Question: Describe this figure in one sentence.
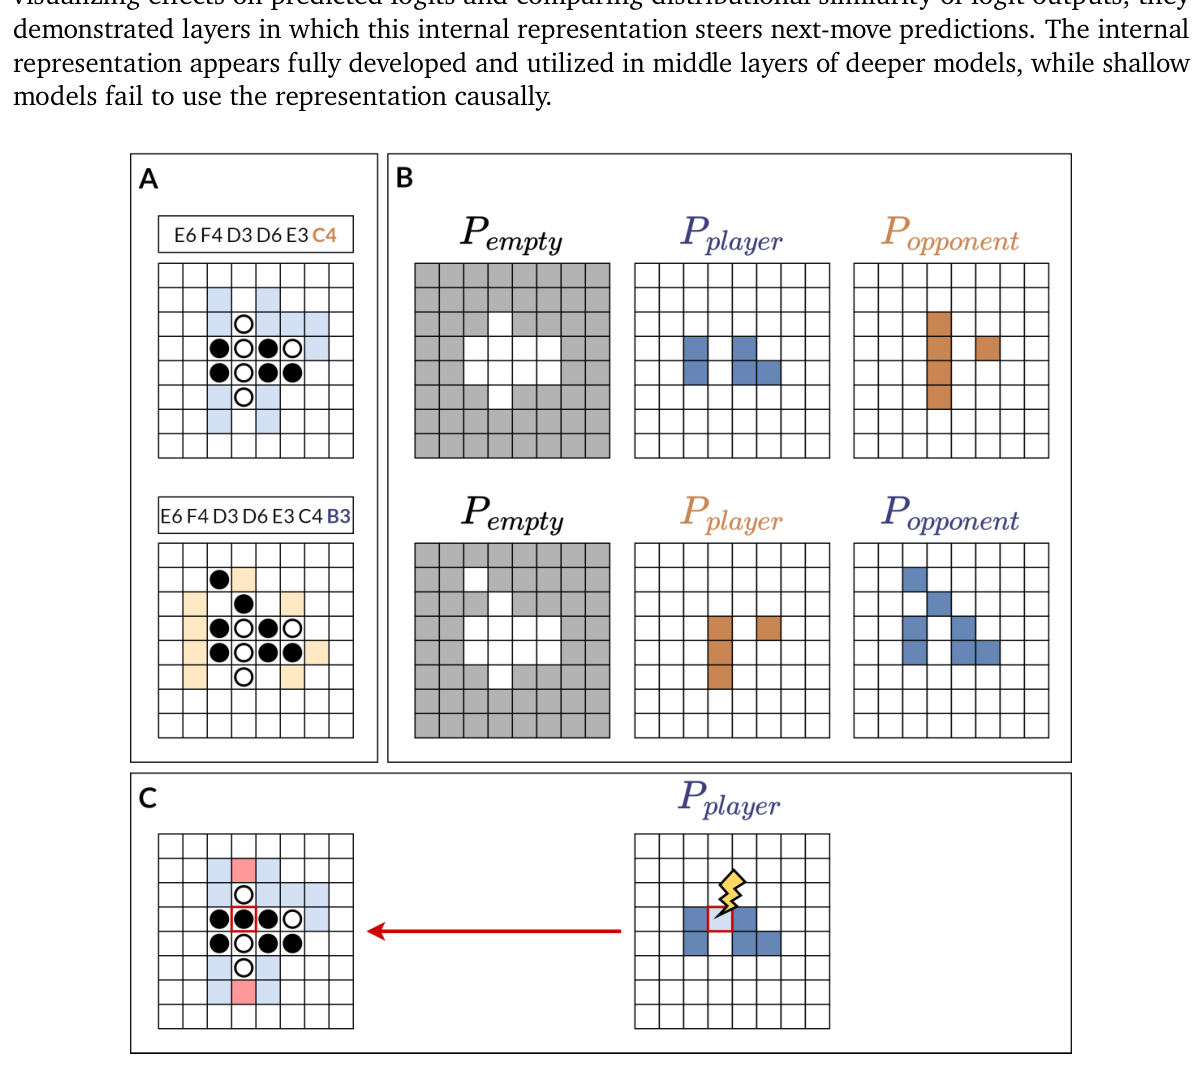
Answer: | Emergent representations of the board state in Othello-GPT (adapted from Nanda et al. (2023)). The model represents board states relative to the current player. A. The ground truth board states at two consecutive time steps. Colored tiles show legal moves for the current player (light blue for black and light orange for white). B. The board states at the same two time steps decoded by linear probes. The probes are trained to classify the board relative to the current player: empty for empty tiles, player for tiles occupied by the current player, and opponent for tiles occupied by the current player’s opponent. Note that the player and opponent colors are flipped between the two time steps, as the current player changes. C. We can intervene on the model’s internal board state representation by pushing an empty tile’s representation in the direction of the player vector, to make the model represent that tile as occupied by the current player. This simple linear intervention is